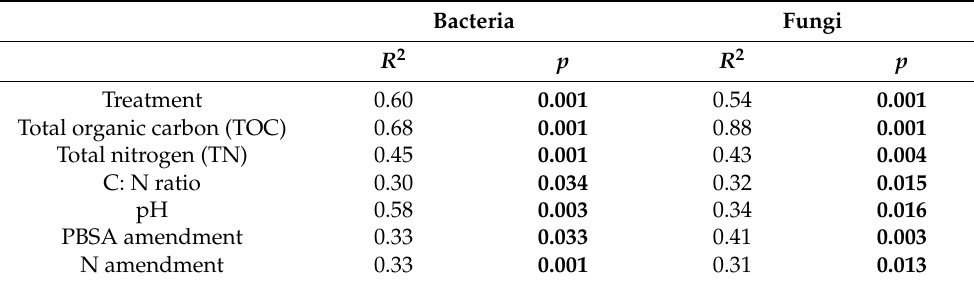
Table 1. Goodness of fit statistics ( R 2 ) of treatment and mean of the soil physicochemical parameters fitted to the nonmetric multidimensional scaling (NMDS) ordination of bacterial and fungal com- munity composition based on presence/absence data and Jaccard distance similarity of soils in all treatments. Bold p values indicate statistical significances p < 0.05.